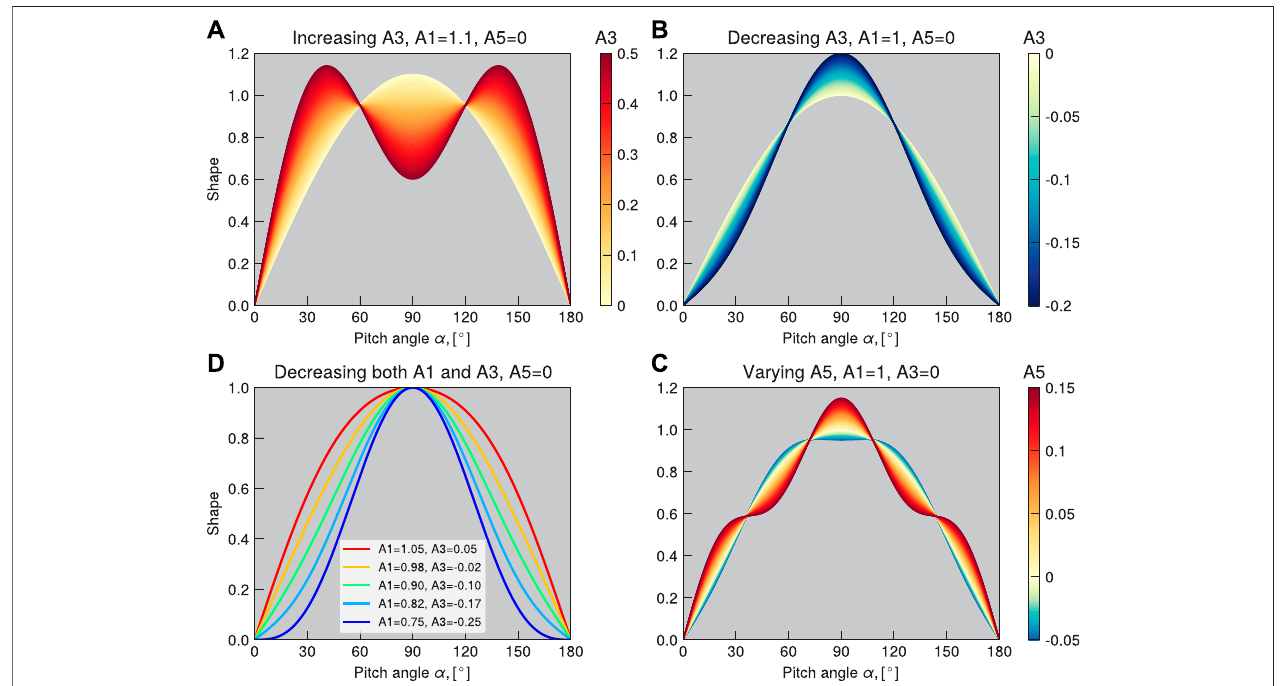
FIGURE2| SketchesofPADshapesresultingfromdifferentcombinationoftheA1,A3andA5coef fi cients. (A) Increasingthebutter fl ycoef fi cientA3under fi xedA1 and A5 = 0 leads to stronger 90 ° minima; (B) negative values of A3 (also under fi xed A1 and A5 = 0) lead to more anisotropic pancake distributions; (C) decreasing both A1 and A3 also creates steeper pancake PADs; (D) Negative A5 values result in fl at-top PADs, while positive A5 values correspond to cap PAD shapes.